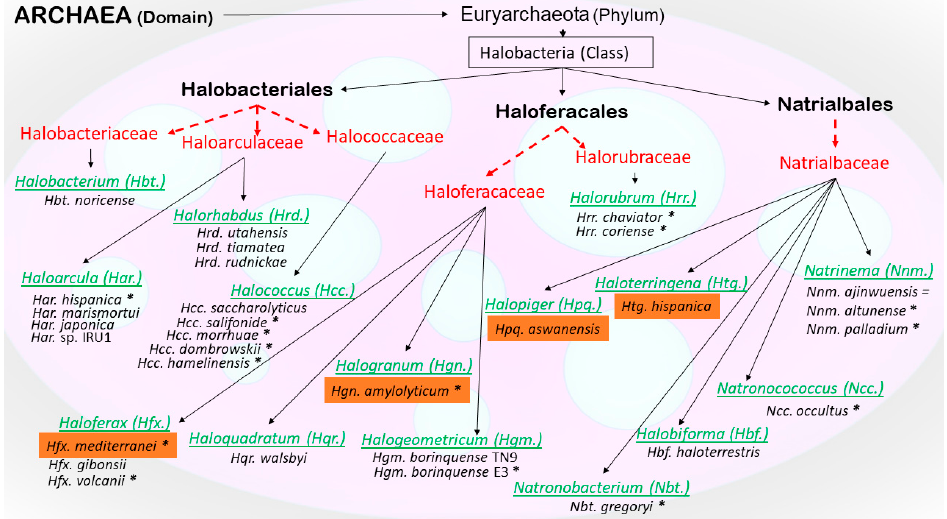
Figure 1. Extract from the phylogenetic tree of haloarchaea, selecting those species reported to accumulate PHA biopolyesters. Colored (orange) background highlights the limited number of species to date cultivated on bioreactor scale to study PHA production. The asterisks indicate 3-hydroxyvalerate production by the strain from structurally unrelated substrates. (Bold: orders; red: families; italics and underlined : genera; italics :